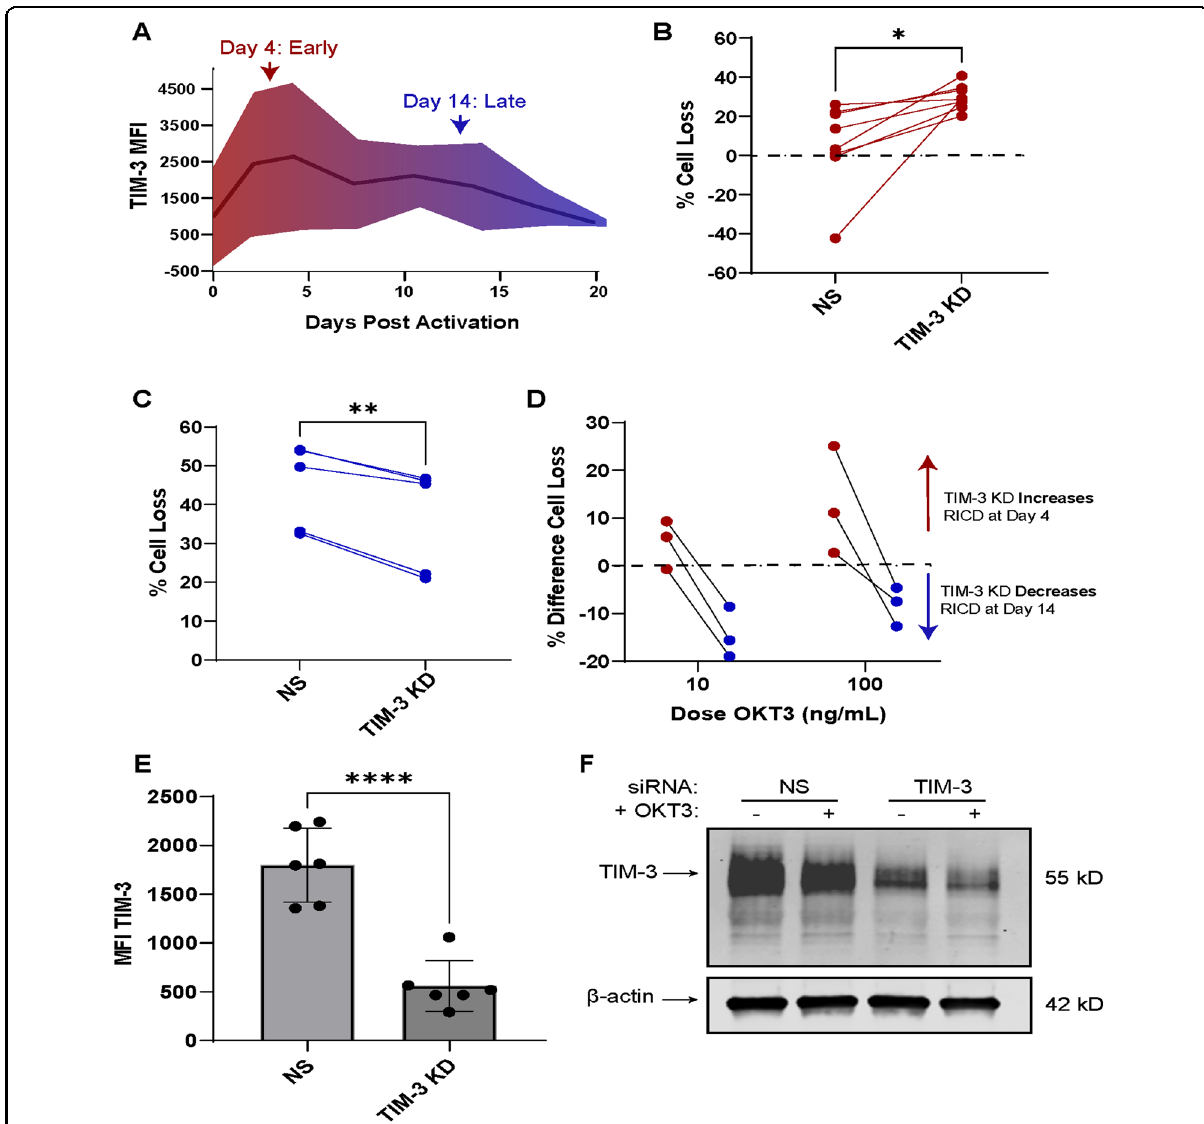
Fig. 1 TIM-3 protects newly activated cells from RICD, but exacerbates RICD in late-stage effectors. A Isolated human CD8 + effector T cells were activated and cultured with exogenous IL-2 for up to 20 days post-activation. Representative image of 3 donors ’ TIM-3 surface expression as assessed by fl ow cytometry; mean fl uorescence intensity (MFI) is represented by the black line, outer edges represent standard deviation. B Puri fi ed CD8 + T cells were electroporated on day 0 with either TIM-3-speci fi c siRNA (TIM-3 KD) or nonspeci fi c siRNA (NS) and tested on day 4 for RICD sensitivity by restimulating with 100 ng/mL OKT3 antibody overnight. Cell loss was assessed by propidium iodide staining and fl ow cytometry. Connecting lines represent individual donors. C Cells were assessed as in ( B ) for death sensitivity at day 14 post-activation. D Differences in % cell loss, calculated per donor by subtracting NS % cell loss from TIM-3 KD % cell loss, were plotted for each donor at various concentrations of restimulating antibody OKT3. E Surface TIM-3 knockdown was assessed by fl ow cytometry; TIM-3 MFI of six representative donors are shown. F Cell lysates were collected following restimulation with OKT3 for 4 h and assessed for TIM-3 KD ef fi ciency by immunoblotting; β -actin served as a loading control. Data shown are representative of several donors. Asterisks denote statistical signi fi cance using the following tests: B paired t test, p = 0.0156; C paired t test, p = 0.031; E paired t test, p <